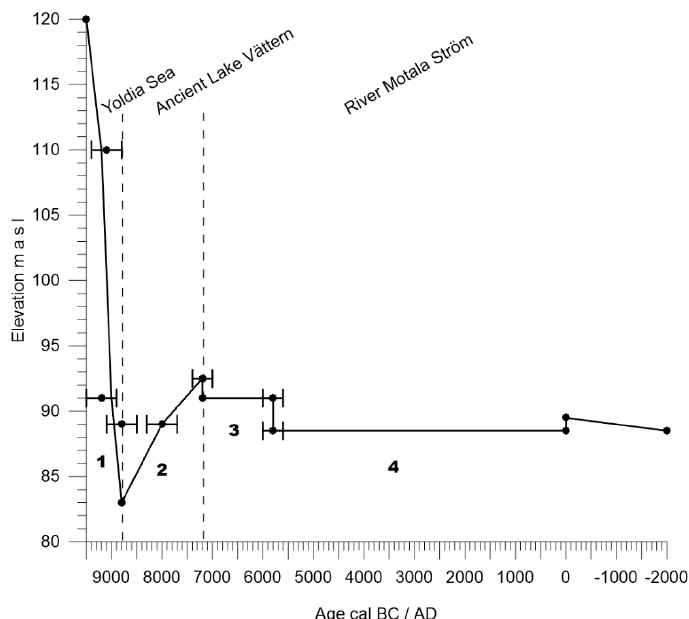
Figure 9. Shore displacement history in Motala. (1) The Yoldia Sea shoreline fall from ca. 120 m a.s.l., and Fågelstakärret fen (110 m a.s.l.) [19], Lake Kanaljorden (estimated threshold 91 m a.s.l.), and Lake Strandvägen (estimated threshold 89 m a.s.l.) become isolated around 8800 cal BC. Ancient Lake Vättern (ALV) is isolated from the sea and drops to ca. 83 m a.s.l. (80–86; [27,30]. (2) ALV transgression starts as the northern connection is closed or possibly begin as part of the Ancylus Lake transgression. The Strandvägen and Kanaljorden basins become inundated shortly after 8000 cal BC. (3) River Motala Ström is first formed between 7500–6900 cal BC, and this first channel head (at the first rapid) was located east of Strandvägen. As it quickly erodes through glaciofluvial deposits, the Lake Vättern water level drops to ca. 91 m a.s.l. The Strandvägen site becomes an island, with early settlement remains, and the Kanaljorden basin most likely becomes part of the Lake Vättern beach zone during the Lake Vättern stillstand. (4) At 5800 cal BC, the headward erosion has moved the channel head west to Strandvägen, and the Lake Vättern shoreline falls to ca. 88.5 m a.s.l., or slightly higher. The main Mesolithic settlements are founded at the first rapids. During the Early Iron Age (ca. 200 cal BC-100 cal AD), the mean water level rises slightly, accommodating for accumulation of fen- and river peat in the backwater at Strandvägen. Events are based on one or several 14 C-dated (2 σ error) units or